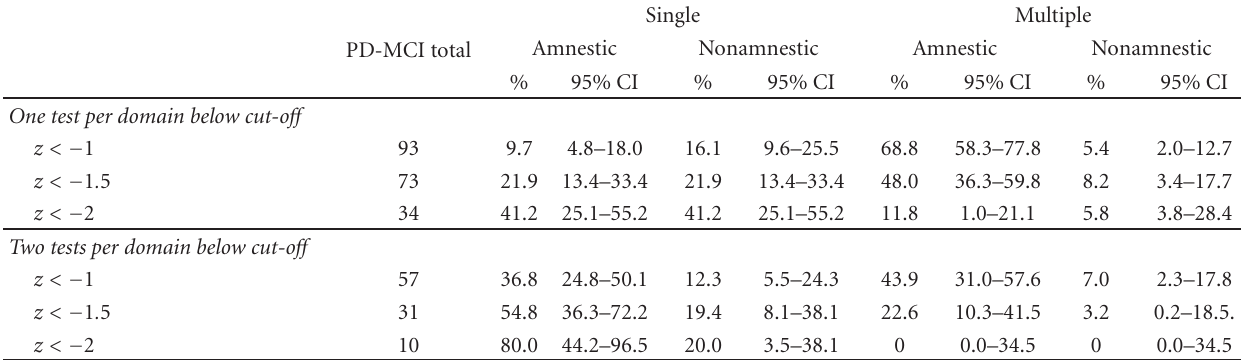
Table 3: Percentage (including 95% confidence interval, 95% CI) of Parkinson patients with minimal cognitive impairment (PD-MCI) and without (PD-noMCI) in regard to di ff erent PD-MCI